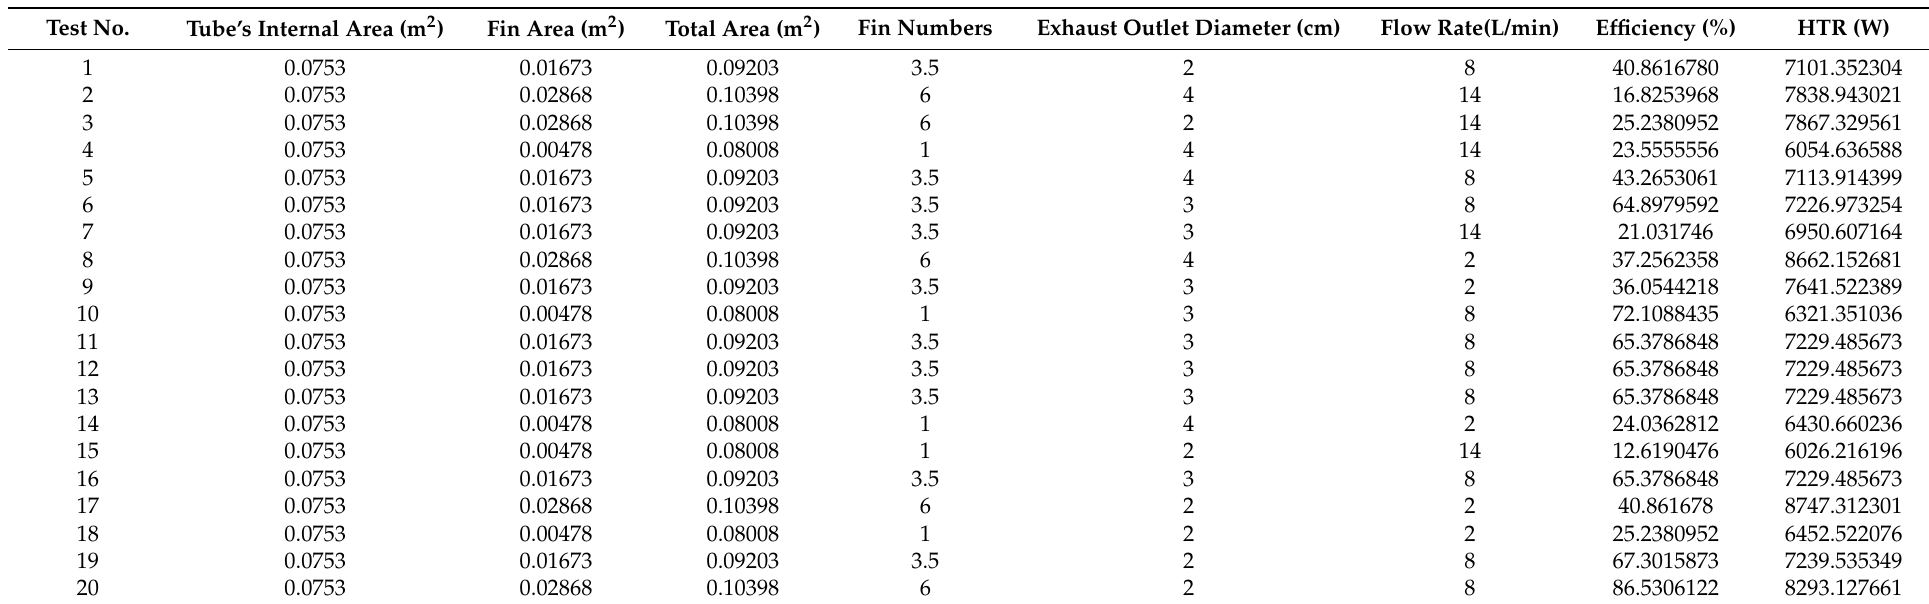
Table 1. Obtained values of efficiency and HTR at different levels of the studied